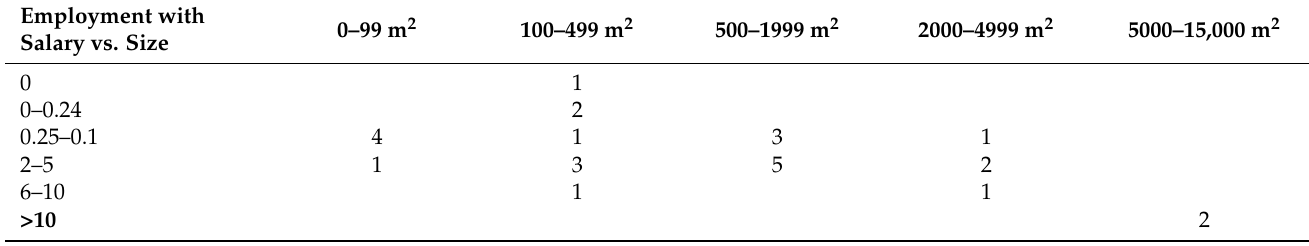
Table 3. Number of salaried jobs according to the size range of the aquaponic system.